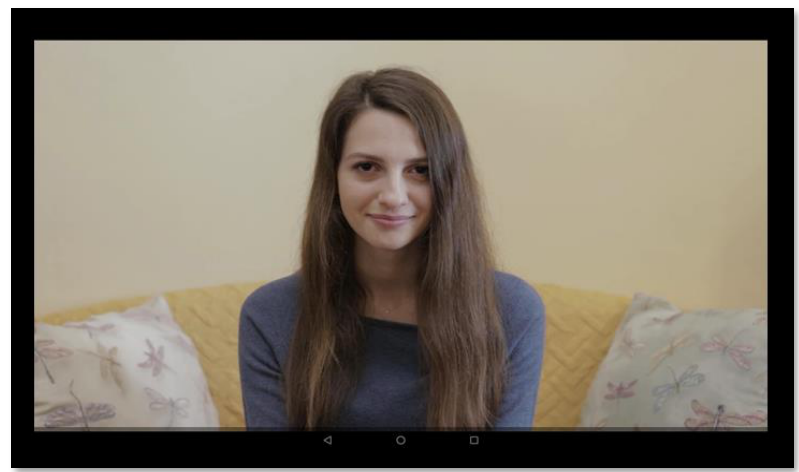
Figure 20. Post-production phase: shooting the pedagogical agent.